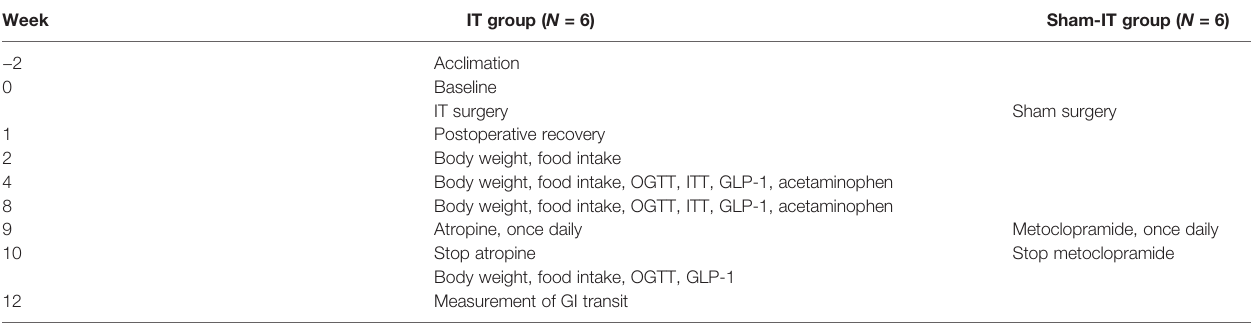
TABLE 1 | Timeline of the